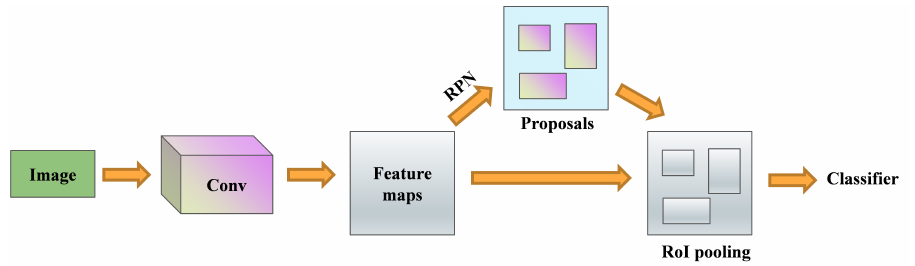
Figure 2. The basic structure of Faster